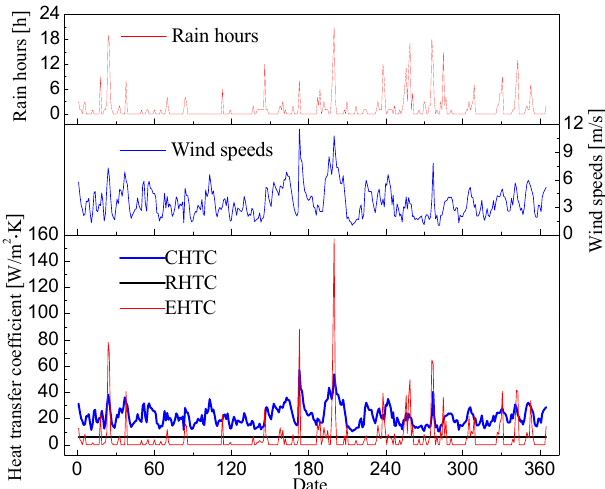
Figure 11. Daily variation relationship between heat transfer coefficients, wind speeds, and rain hours in the tropical island region.